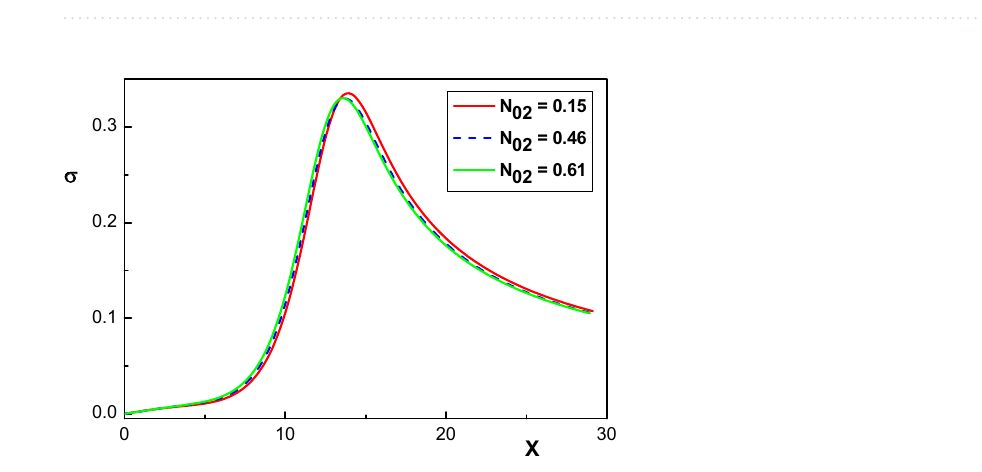
Figure 1. Variation of the normalized density distribution of the net positively charged particles ( N + ) and electrons ( N e ) versus the normalized distance from the sheath edge for α 1 = 0.001 , ϕ w = − 90 eV , for different values of krypton concentration N 02 .